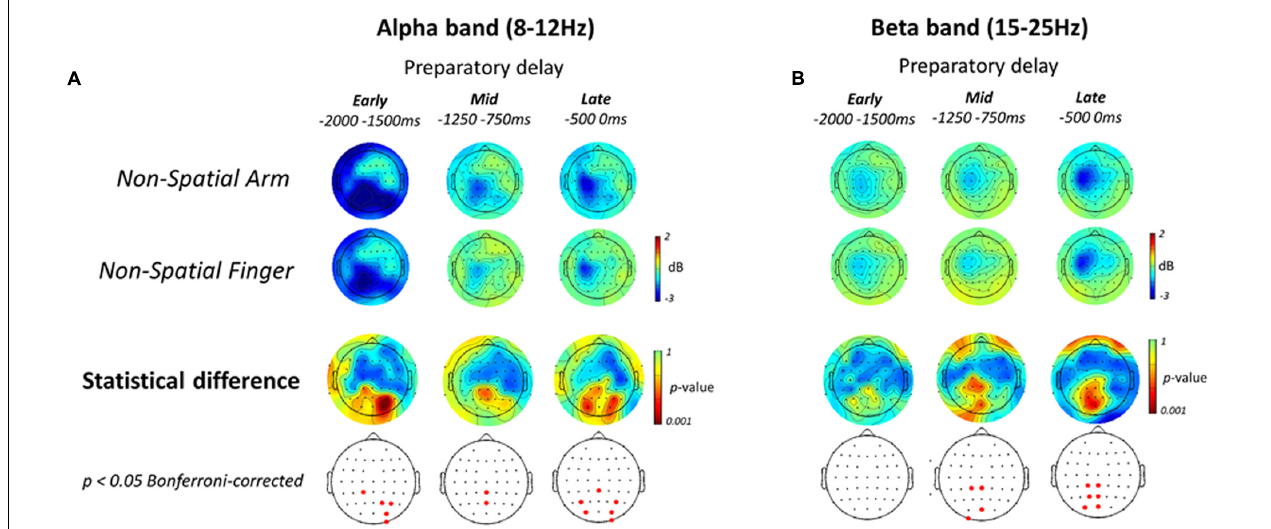
FIGURE 6 | Electroencephalography alpha- and beta-band ERD during Non-spatial reach preparation. ( A , top two rows) Scalp topographic maps of alpha-band ERD in the Early, Mid, and Late planning epochs of the preparatory delay period, shown for the Non-Spatial Arm and Non-Spatial Finger conditions. ( A , bottom two rows) Scalp topographic maps of the statistical difference in alpha-band ERD between the Non-Spatial Arm and Non-Spatial Finger conditions, along with the electrodes that survive a p < 0.05 Bonferroni-corrected criterion. (B) Same as (A) but for beta-band ERD.